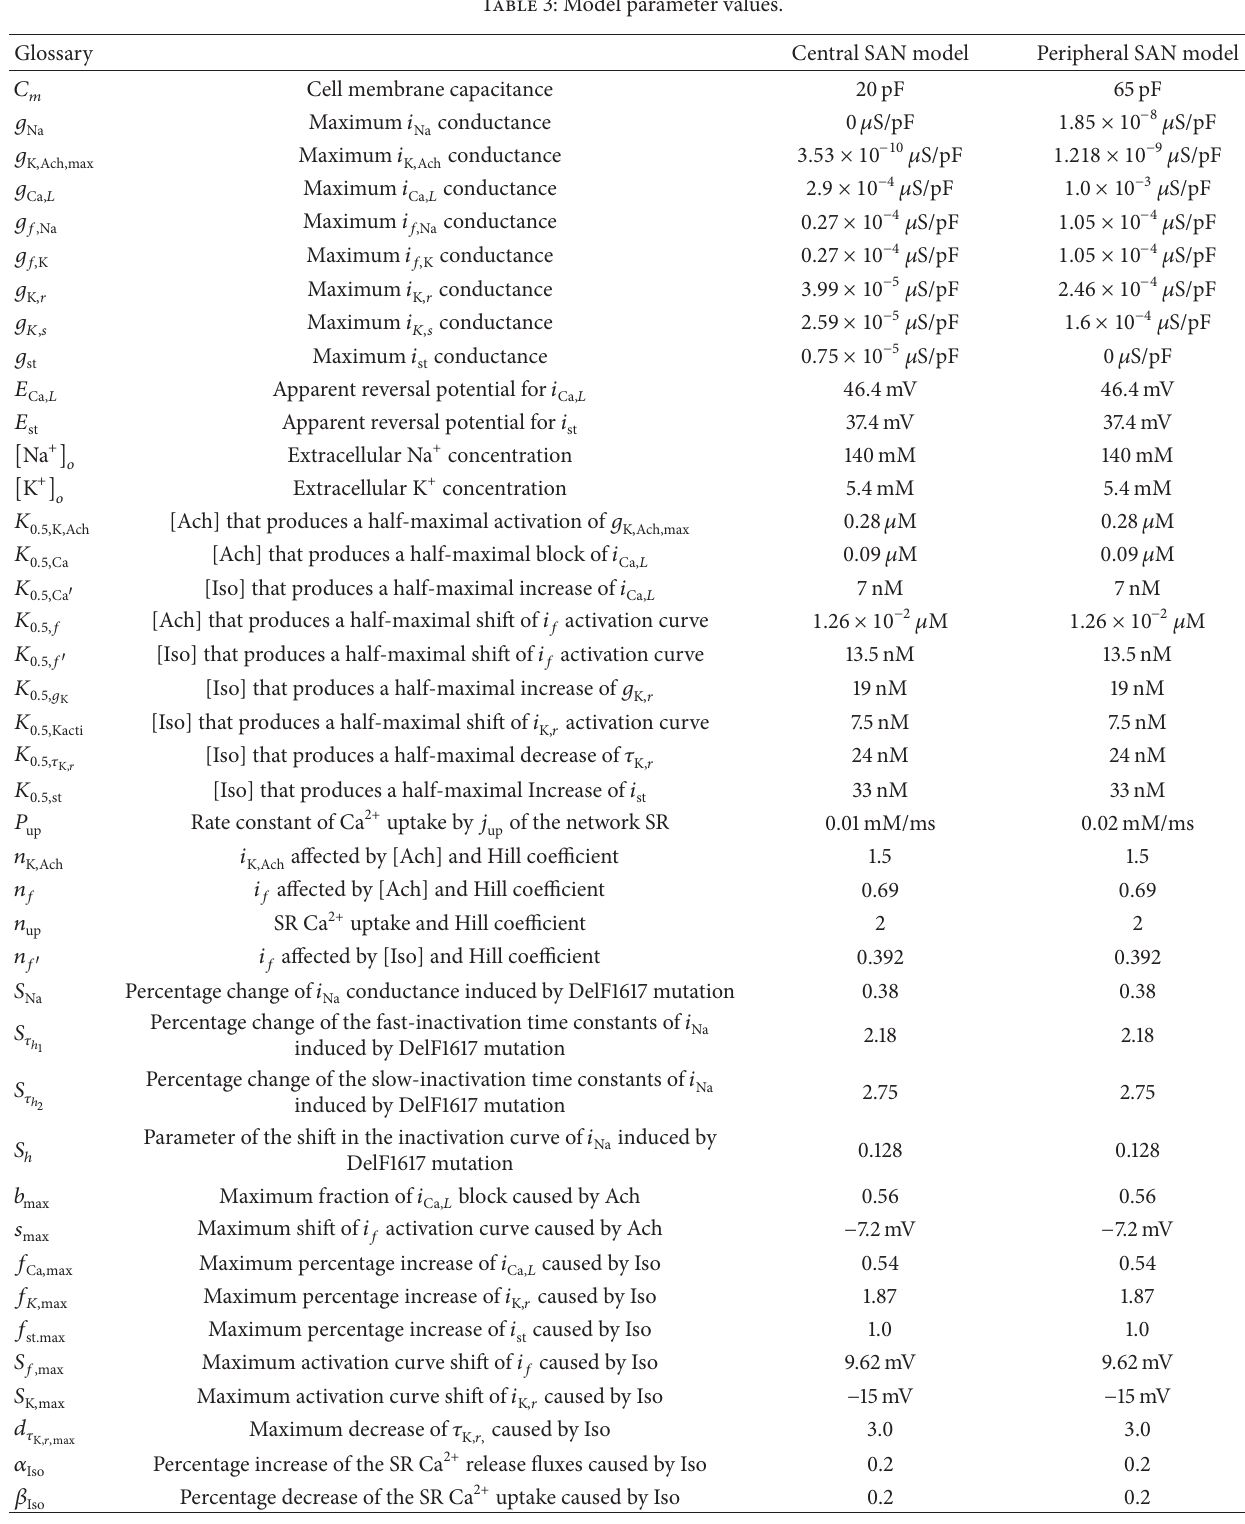
Table 3: Model parameter